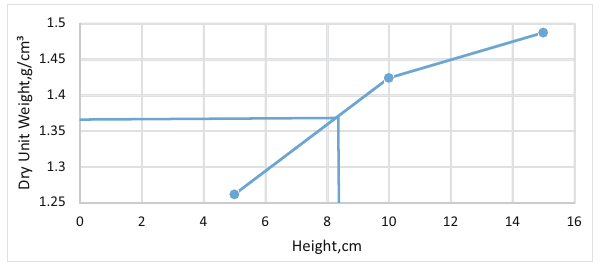
Figure 6: Relationship between dry unit weight and